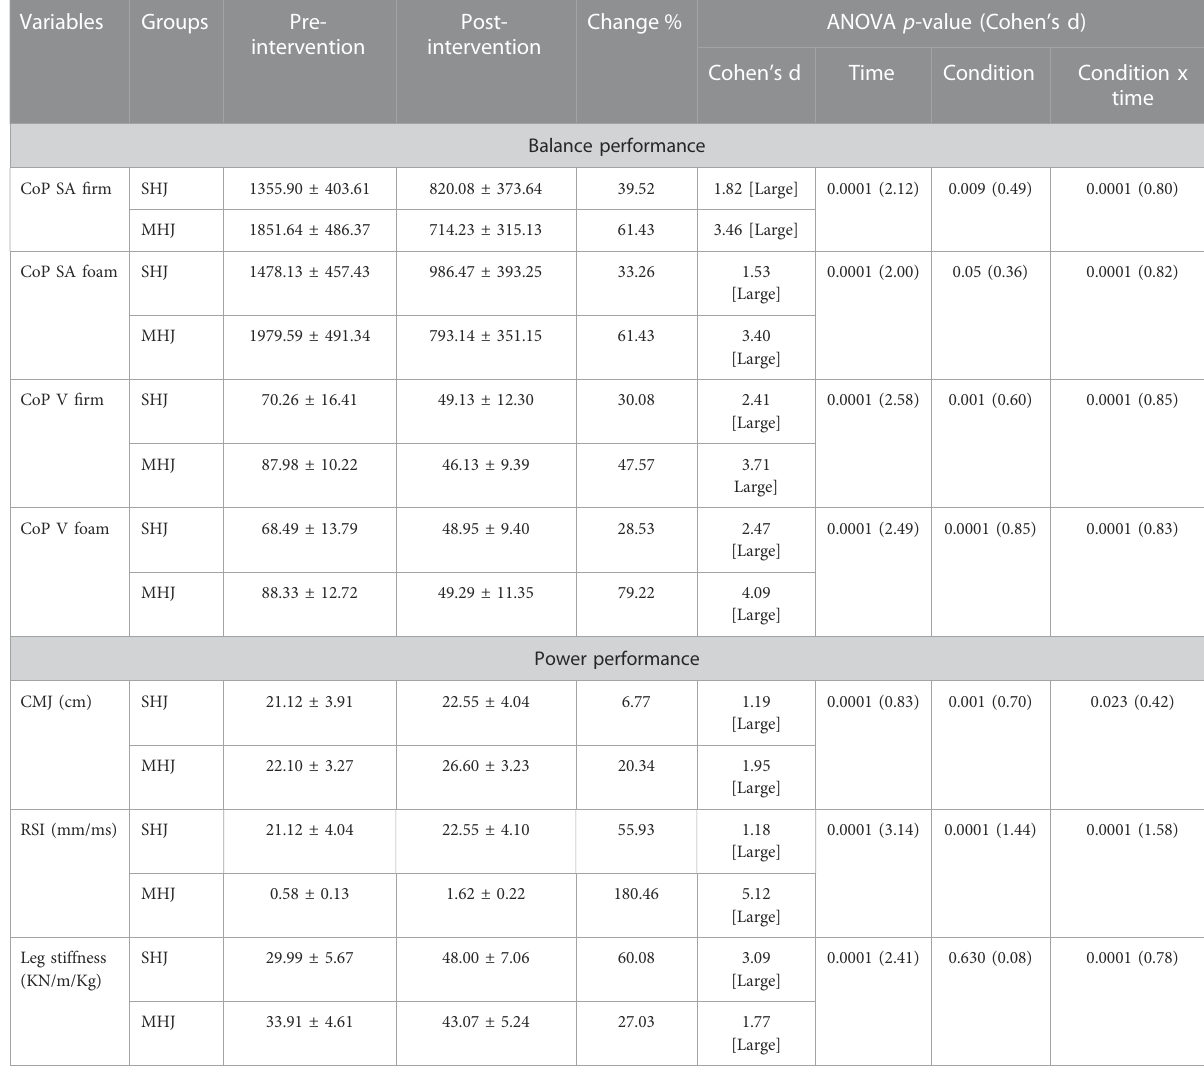
TABLE 3 Acute effects of maximal versus sub-maximal hurdle jump exercise protocols on measures of balance, vertical jump, reactive strength and leg stiffness in male youth volleyball players (means ± standard deviations).